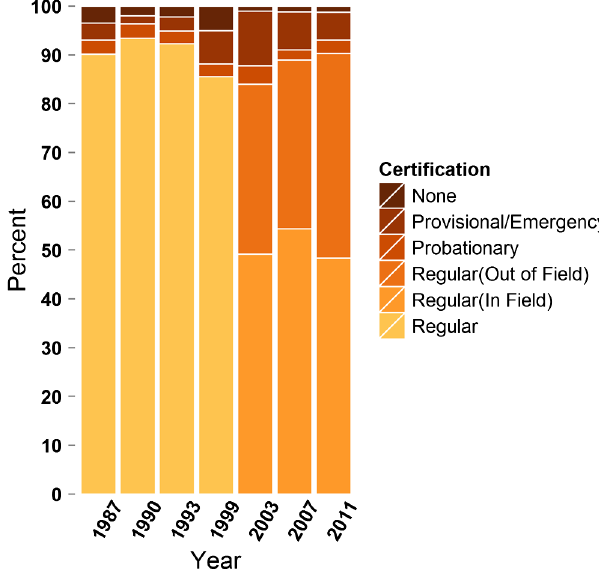
FIG. 4. Proportion of physics teacher with each certification status calculated for each survey year (standard error ≤ 6 . 61